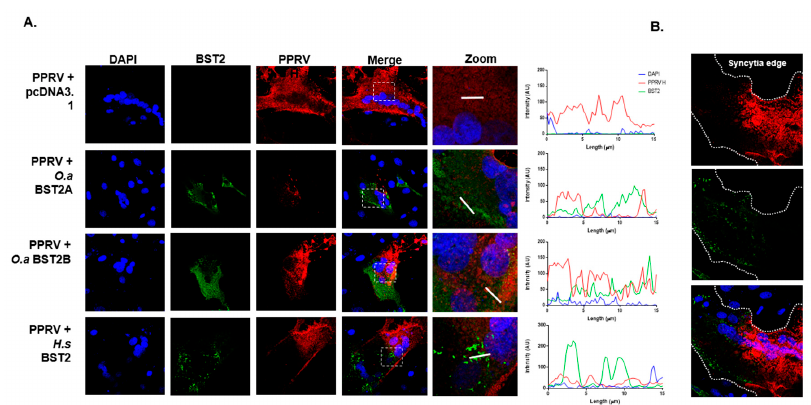
Figure 6. H protein production and trafficking is inhibited in PPRV-infected BST2-overexpressing cells. PPRV H distribution is modified in BST2-transfected infected cells. ( A ) Vero cSLAM cells were transfected with plasmids expressing the indicated BST2 protein (or mock transfected) before being infected with PPRV Tu00 at an MOI of 0.1. Cells were fixed at 16 h post infection before staining with relevant antibodies (PPRV H, red and BST2, green). Micrographs were taken on a Leica confocal microscope with line of interest analysis of colocalization performed using the inbuilt software. The white boxed insets in the merged panels reflect the region chosen for analysis in the “zoom” panel (right), with the x-axis on the colocalization graphs representing the 15 µ m white lines indicated on the adjacent zoomed images. ( B ) A zoomed image of a single large BST2-expressing syncytia indicating the approximate position of the plasma